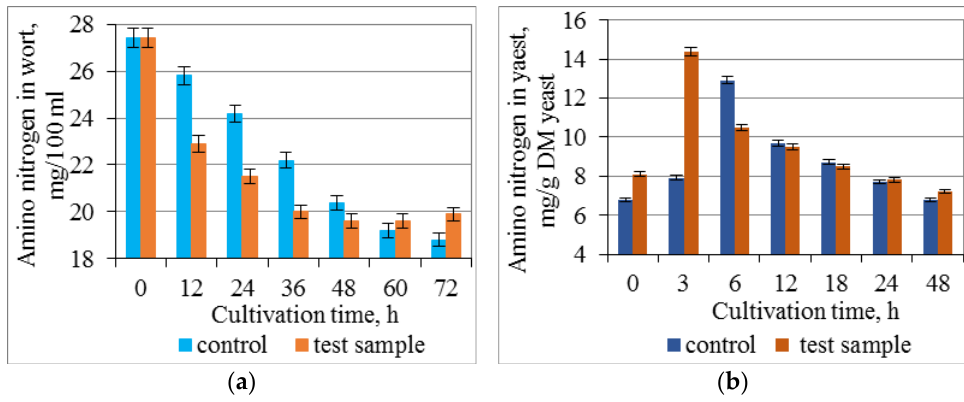
Figure 5. Amino acid nitrogen in culture medium ( a ) and in yeast ( b ) in the activated microbial culture. In panels ( a ) and ( b ), the values with a statistically significant difference ≤ 0.05 are shown.